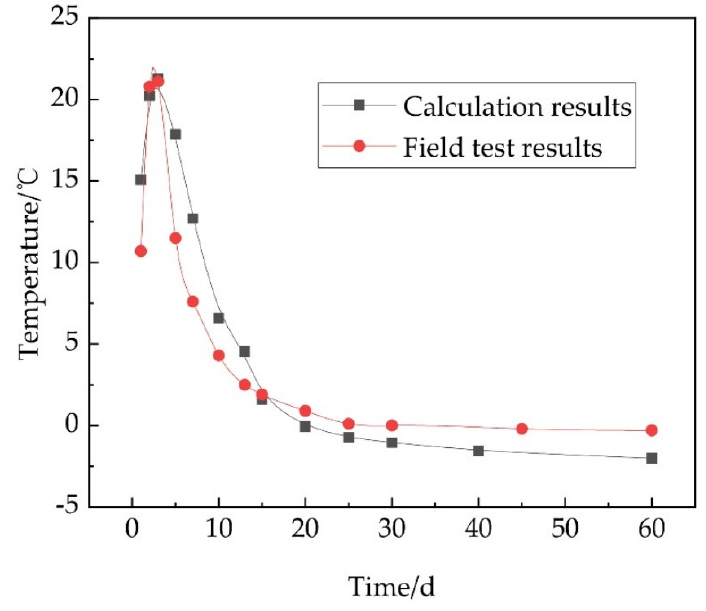
Figure 6. 0–50 d pile core temperature